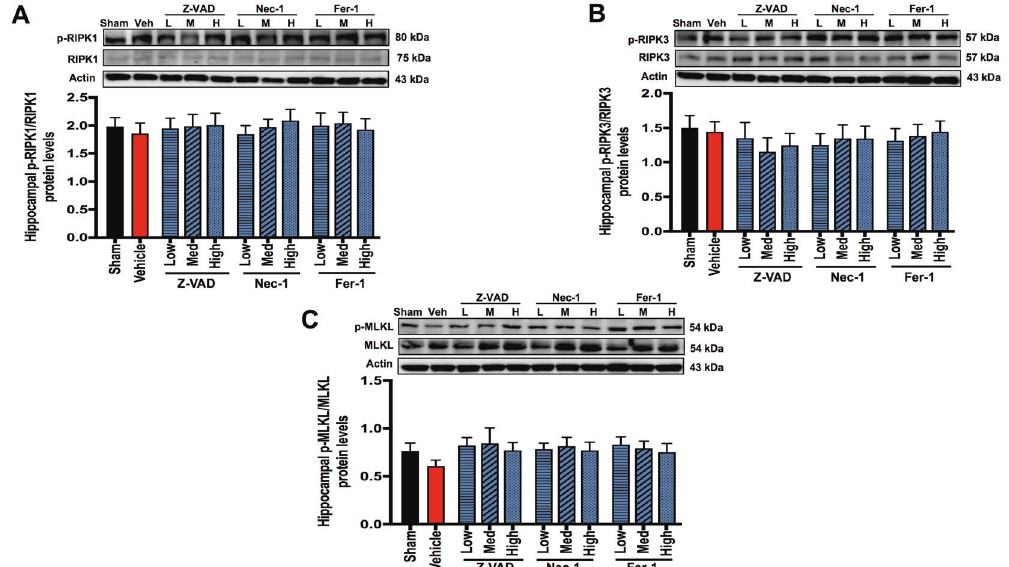
Fig. 5 The effects of cell death inhibitors on hippocampal necroptosis signaling pathways. A p-RIPK1/RIPK1 protein expression; B p-RIPK3/ RIPK3 protein expression; C p-MLKL/MLKL protein expression. Data are shown as mean ± SEM. n = 6/group. Veh: cardiac I/R rats treated with vehicle; L: cardiac I/R rats treated with low dose of cell death inhibitor; M: cardiac I/R rats treated with medium dose of cell death inhibitor; H: cardiac I/R rats treated with high dose of cell death inhibitor. I/R ischemia/reperfusion injury, RIPK receptor interacting protein kinases, MLKL mixed lineage kinase domain-like